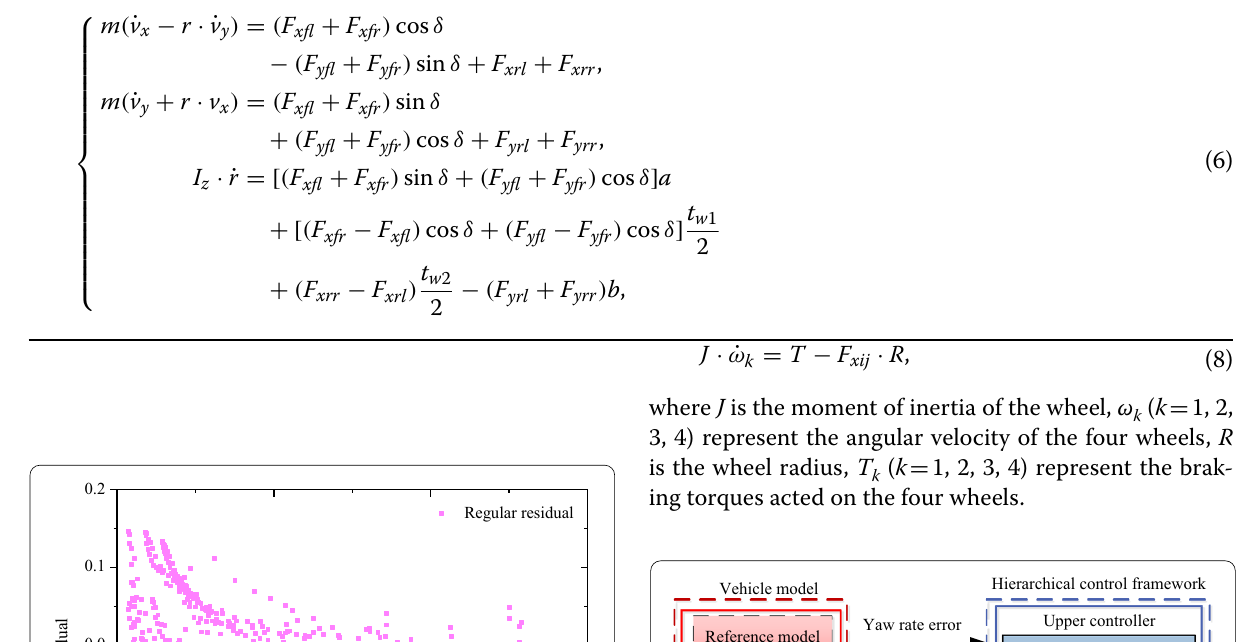
Vehicle model Reference model